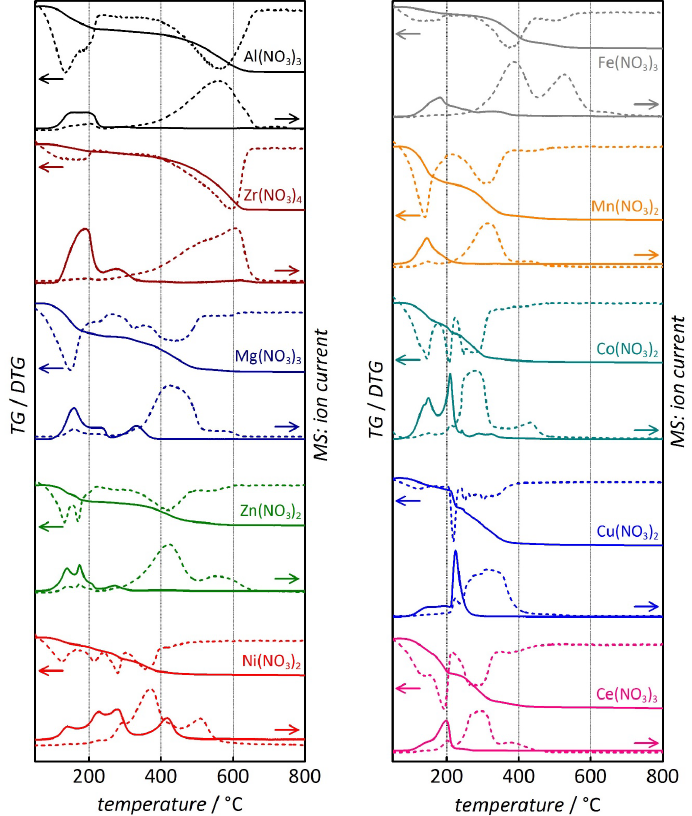
Figure 3. Thermogravimetric/derivative thermogravimetric (solid line TG/dashed line: DTG) and mass ion detection analysis (solid line: m/z = 30 (NO + )/dashed line: m/z = 44 (CO 2+ )) of